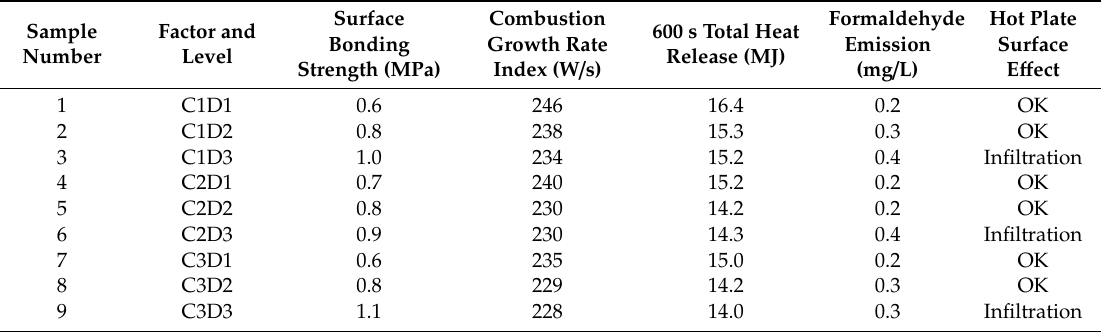
Table 6. Test results of two-time sizing optimization